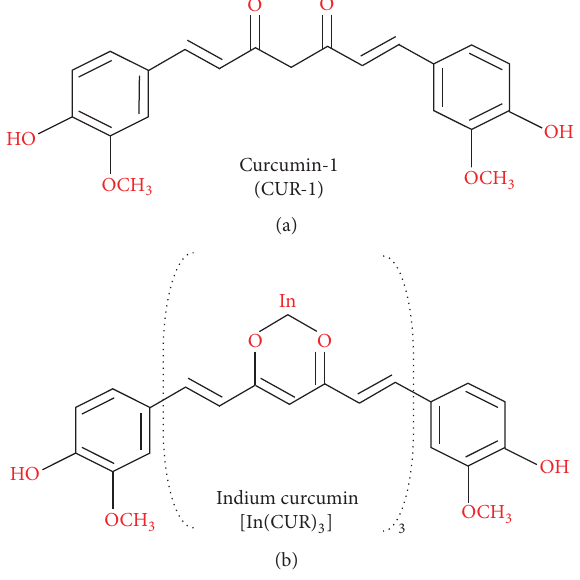
Figure 1: Chemical structures of antibacterial curcumin analogues against S. aureus . Upper panel shows the structure of curcumin-1 [30, 41] while the lower panel shows the metal complexes of cur- cumin, indium curcumin [42, 43]. The chemical structures above were drawn using a free online tool, ChemWriter (http://chemwriter